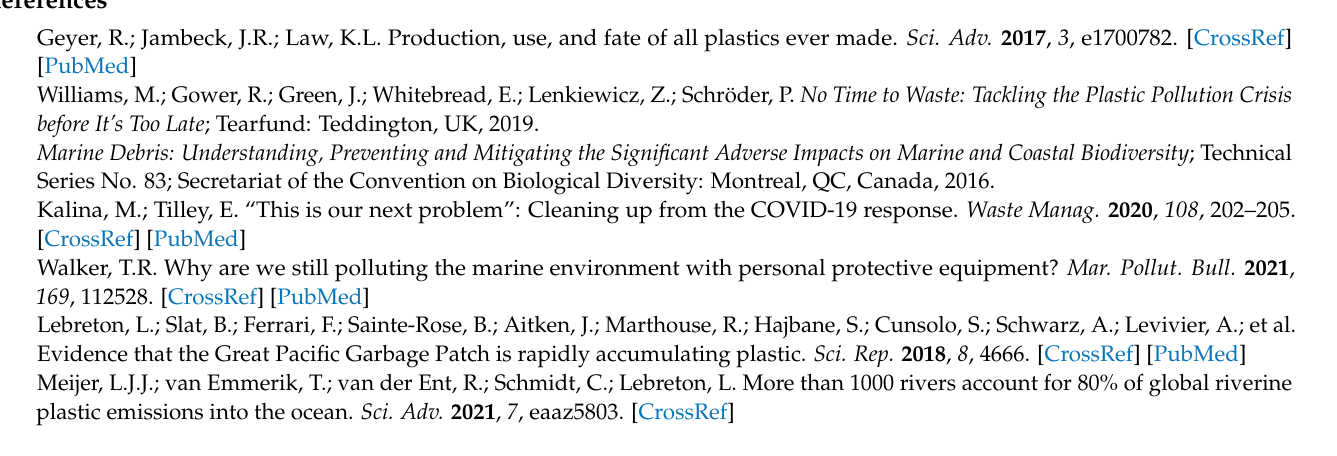
Table preparation, R.T. and P.R.; writing—original draft preparation, R.T. and P.R.;